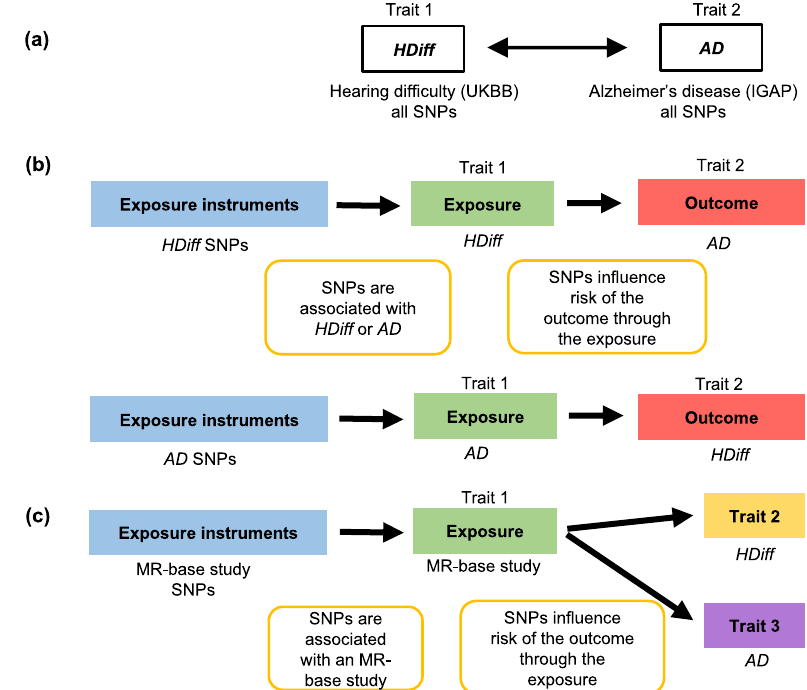
Fig. 2 Assumptions of our genetic correlation and Mendelian randomization analyses. a Genetic correlation using LD score regression between Hearing dif fi culty ( HDiff ) and Alzheimer ’ s disease ( AD ) genome-wide SNPs. b Bidirectional Mendelian randomization using exposure instruments (e.g., genome-wide signi fi cant lead SNPs from HDiff GWAS) in causal association with outcome (e.g., AD ). c Mendelian randomization using SNPs from studies available in MR-base database as exposure instruments in causal association with the outcome for each trait, HDiff , and AD